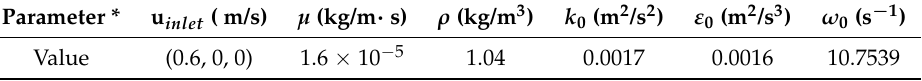
Table 1. The parameters for the flow past a circular cylinder (Re =